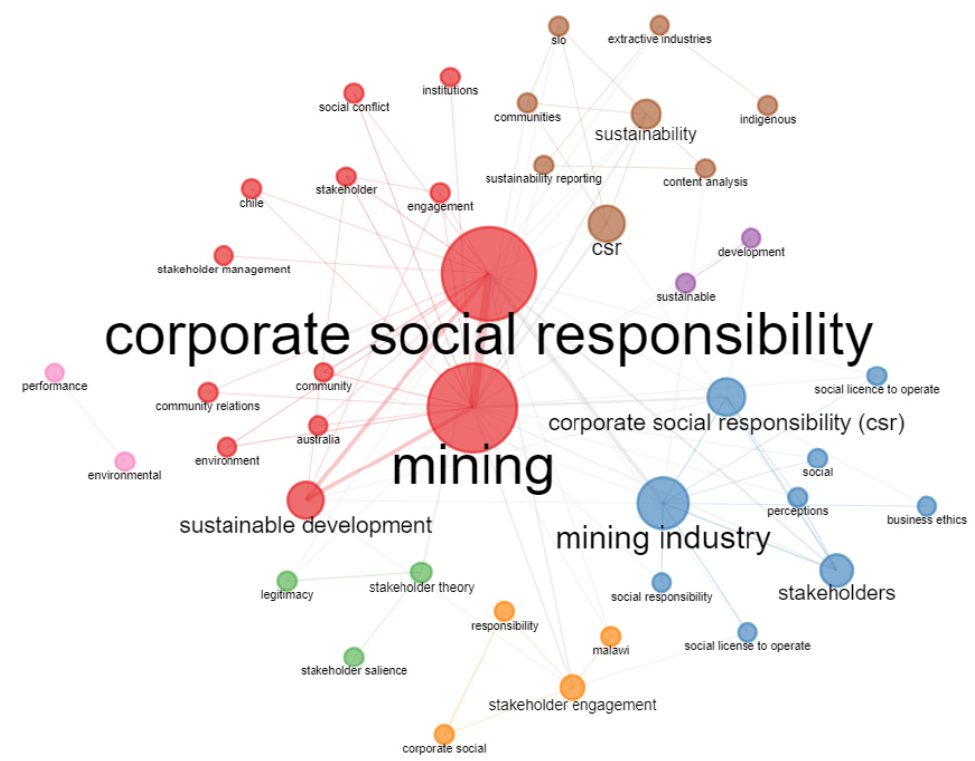
Figure 1. Cluster of words (n = 149 articles).